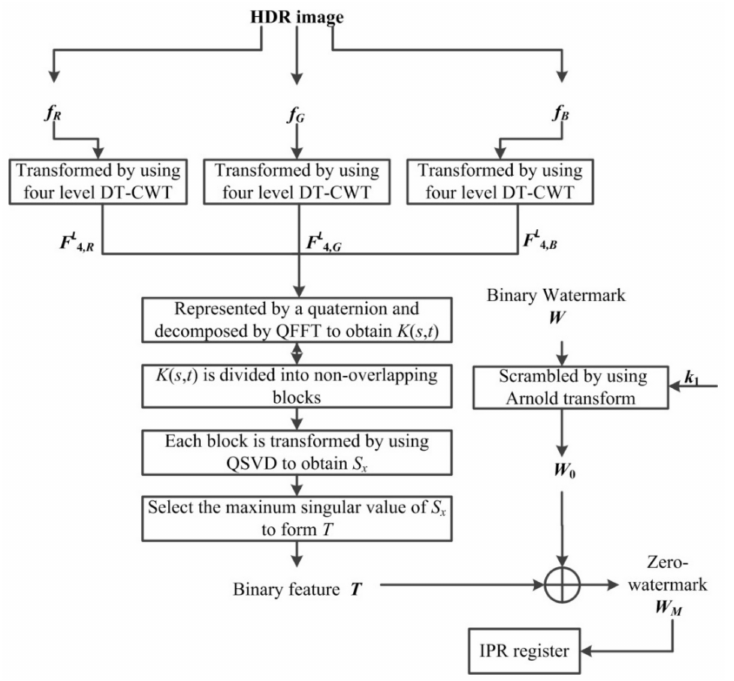
Figure 3. Flowchart of zero-watermark